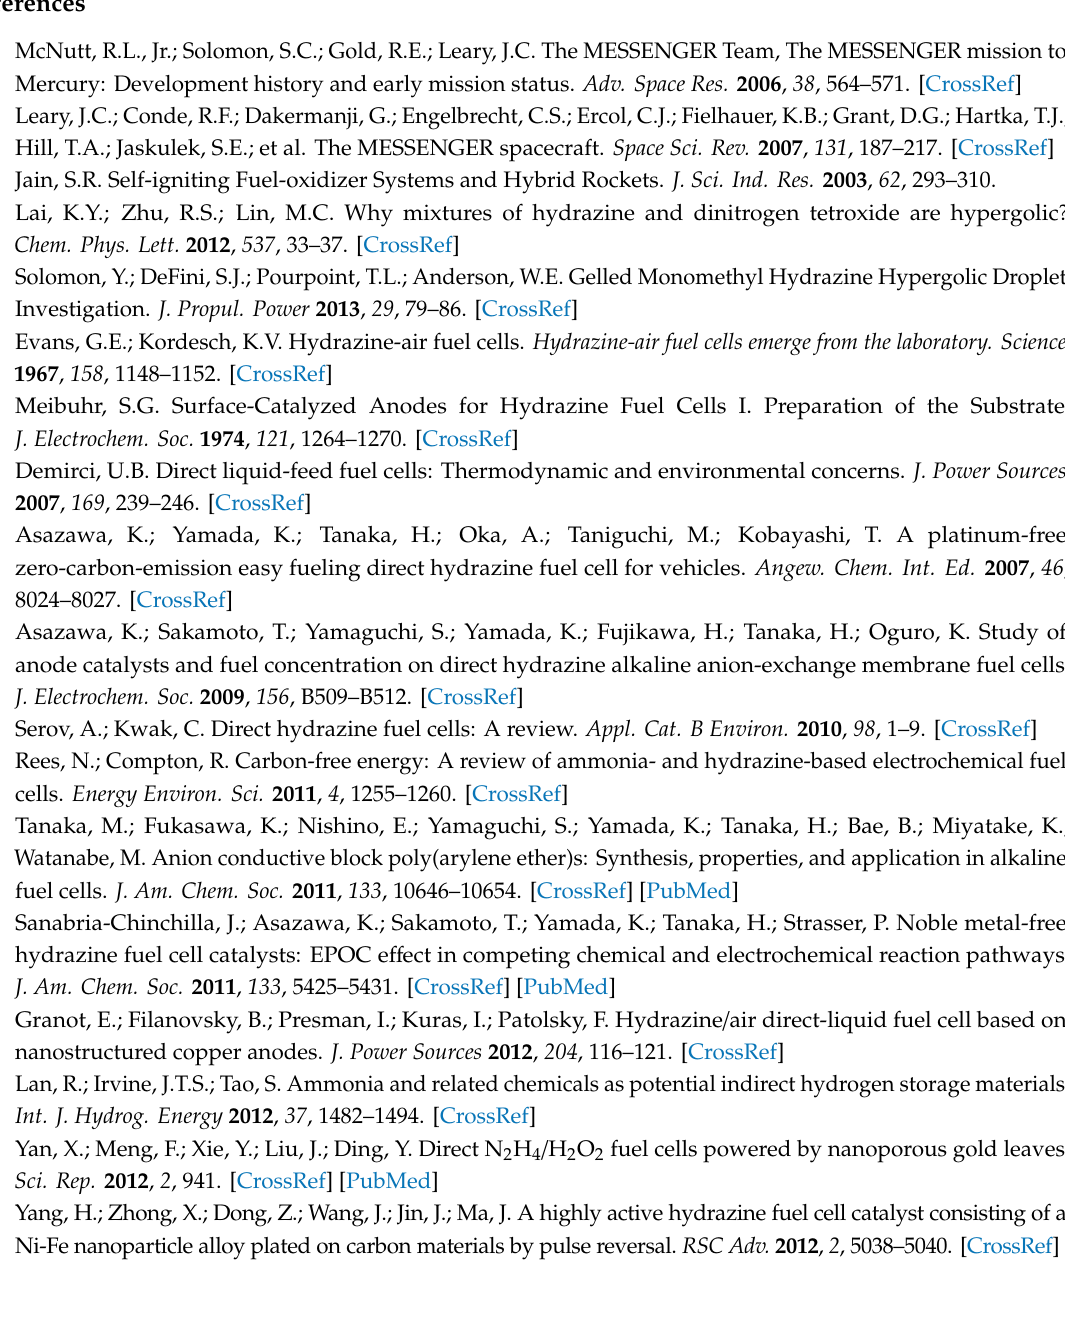
Figure S1: 1 H NMR spectra of polymers (400 MHz, D 2 O,